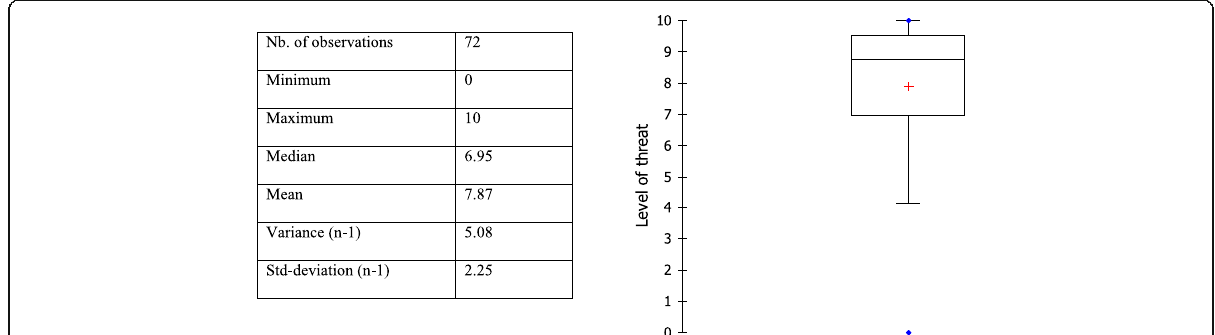
Fig. 8 Answer to the question: “ On this scale, you can set the level of threat that the risks of lahars represent to you? ” (0 = no threat, 10 = a great threat)/Experienced people in risk prone areas ( n =